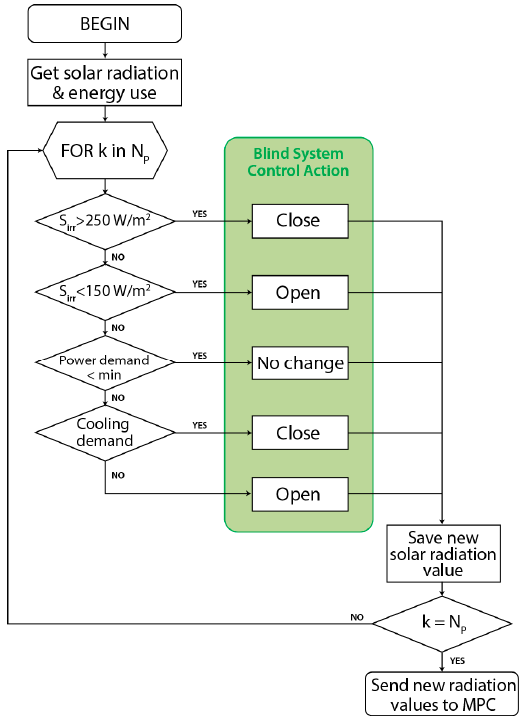
Figure 5. Flow chart representation of the proposed enhanced BSC. Table 5. Reference values and comfort band limits for temperature (in °C). Office hours are considered from 08:00 to 18:00.